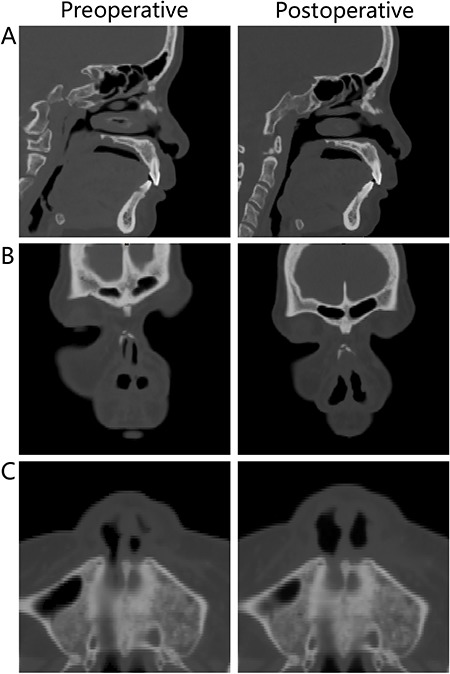
Pre- and postoperative anterior nasal cavity stenosis. A, sagittal and B, coronal computed tomography of the nasal cavity. C, Nasal base view.